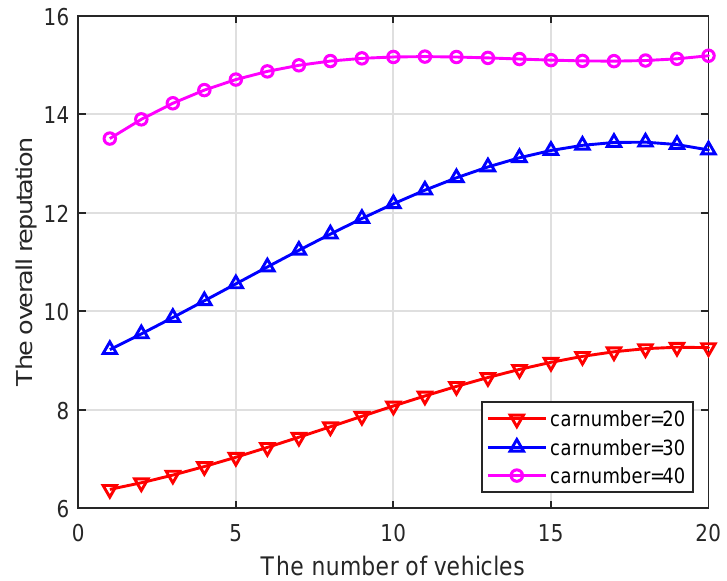
Figure 7. Vehicles vs. The overall